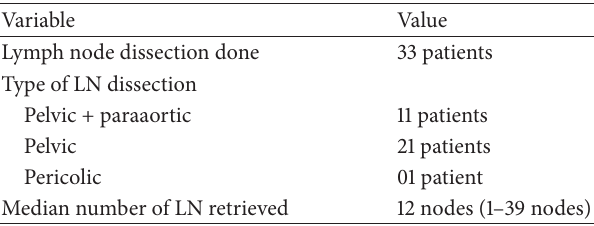
Table 2: Details of lymph node dissection performed.